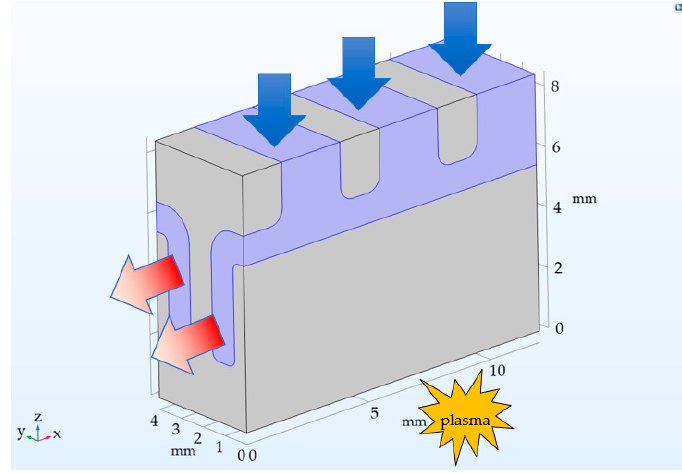
Figure 13. ( a ) Cross-section of ∩ -type lower channel; ( b ) perspective of ∩ -type lower channel.